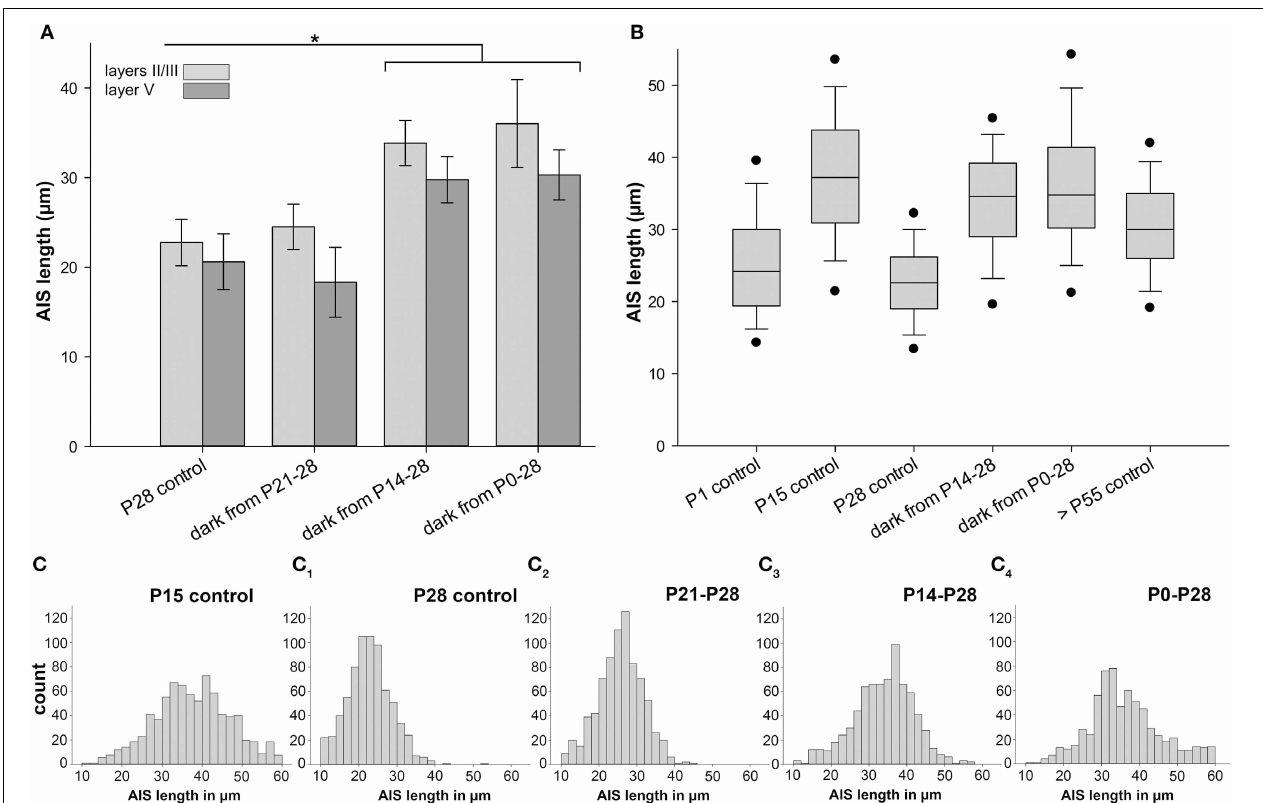
FIGURE 6 | Changes in AIS length after sensory deprivation. Graph in (A) shows results for neurons in layer II/III (light gray) and V (dark gray); all other graphs indicate layer II/III data only. (A) Mice were placed in complete darkness from P21 to 28, showing no change compared to P28 control. Sensory deprivation from P14 to 28 resulted in a significant AIS length increase compared to P28 control. Likewise, dark rearing from birth to P28 resulted in a significant AIS length increase compared to P28 control. (B) Box plot comparison of AIS length percentiles and median in each experimental group revealed that juvenile AIS at P15 and before have a wider distribution of individual lengths. At the age of shortest AIS length (P28), AIS length distribution is the narrowest. Dark rearing from birth to P28 results in a similar length distribution as in juvenile AIS at P15. Adult AIS ( > P55) show